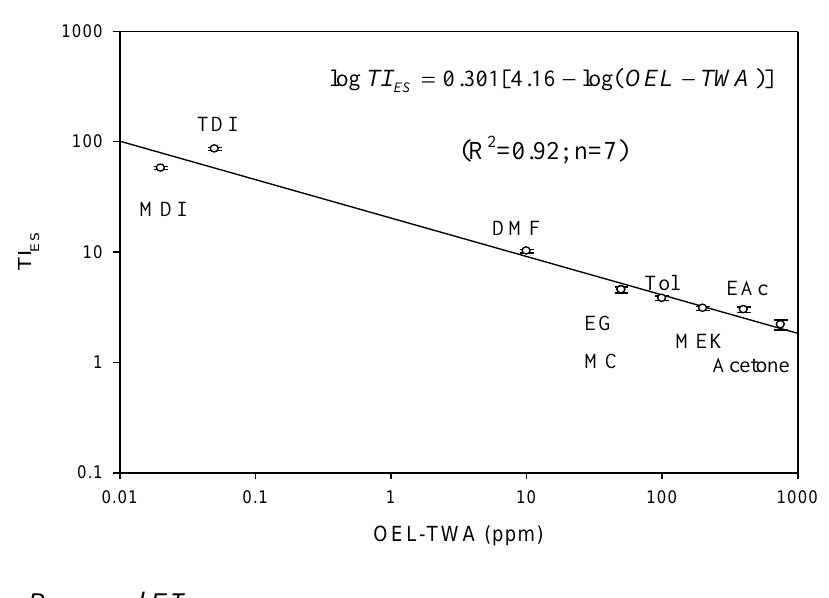
(mean ± 95% confidence interval) and the ES